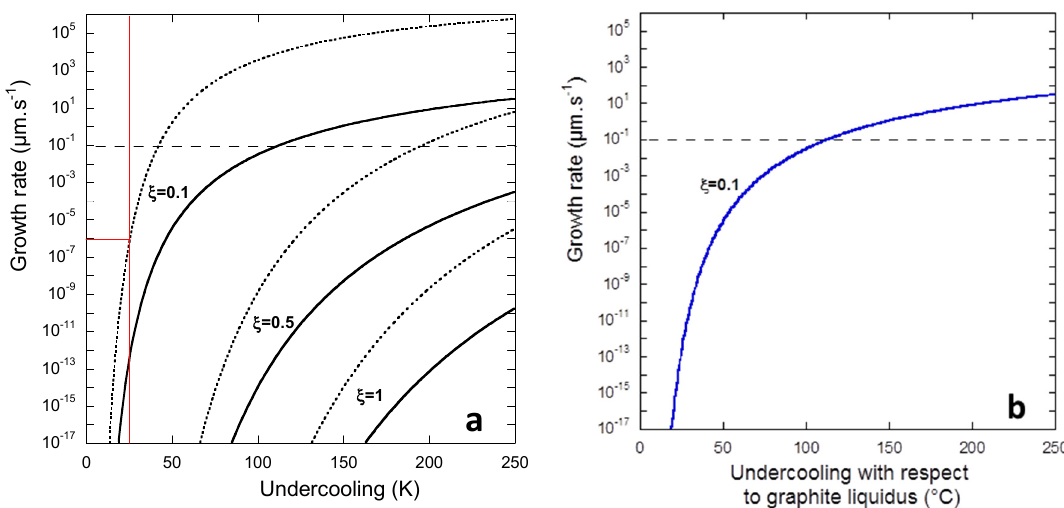
Figure 1. Overall growth rate of a graphite spheroid according to the PNG model as a function of the undercooling with respect to the graphite liquidus. The horizontal line represents the experimental value estimated by Amini and Abbaschian for the thickening rate of lamellar graphite (growth along the basal-c direction). ξ is the diffuseness of the interface. In ( a ) is shown the figure as reproduced by Stefanescu et al. [1] with dotted and solid lines associated respectively to Equation (2) and Equation (3). In ( b ) has been drawn the same figure but with the single curve that should have been considered when discussing our calculation results.